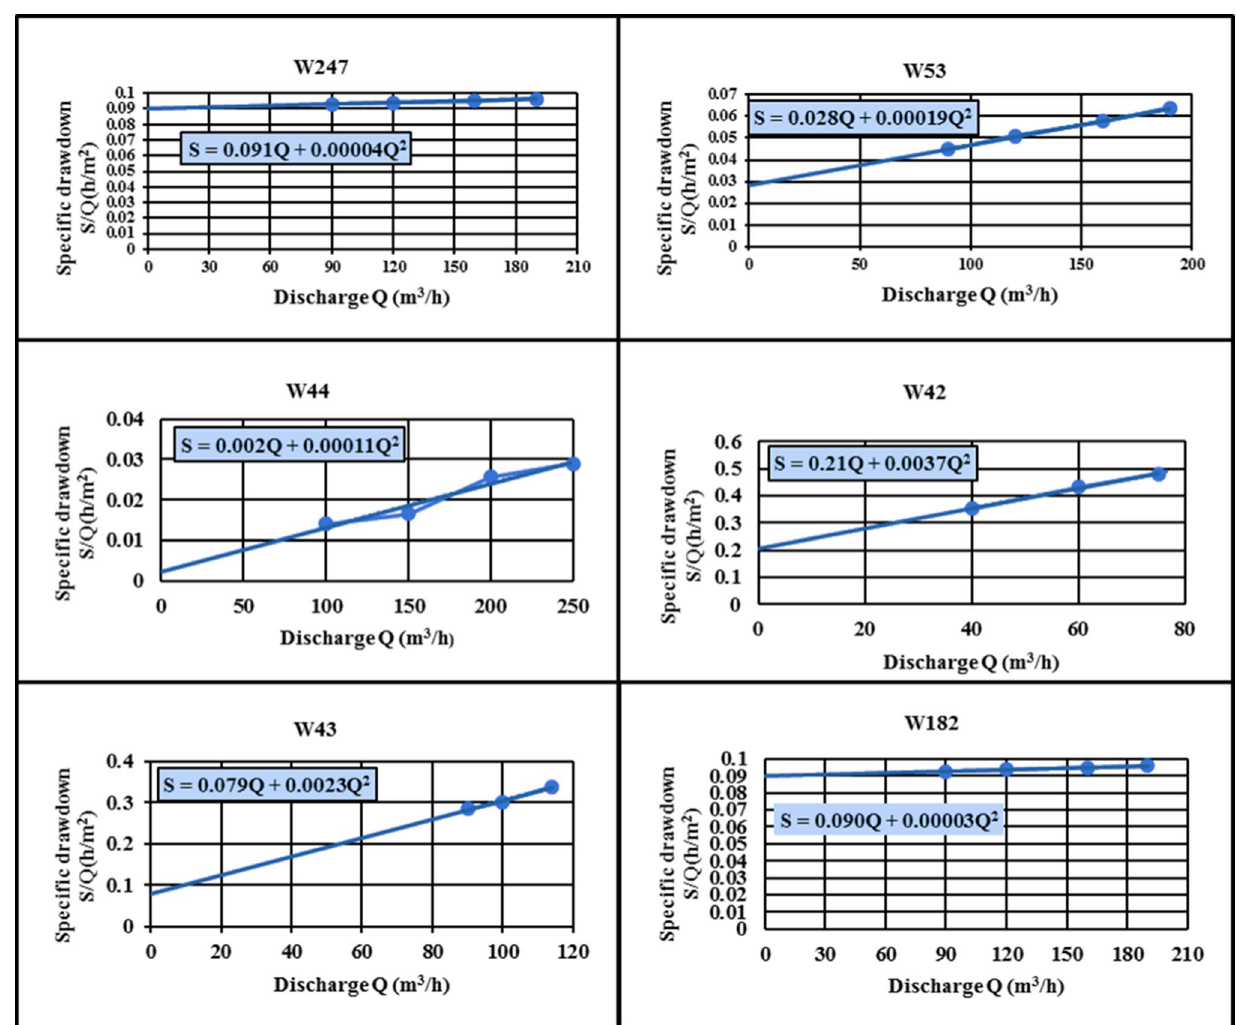
Fig. 11 Step test diagrams from pumping test for the Eocene aquifer, West–West Minya,